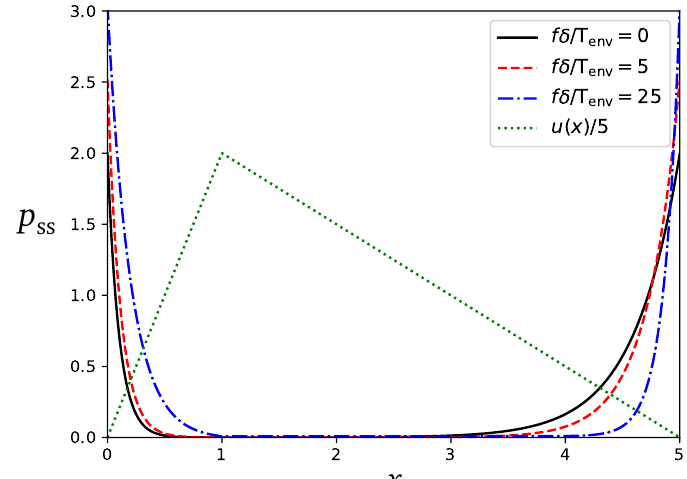
Figure 6: Stationary distribution p triangular potential (62) as a function of x for δ = 5, x ∗ = 1, u for given values of f . The value of γ is immaterial. Solid lines are plots of p from the Eqs. (140)-(146). The green dotted line plots the potential u divided by